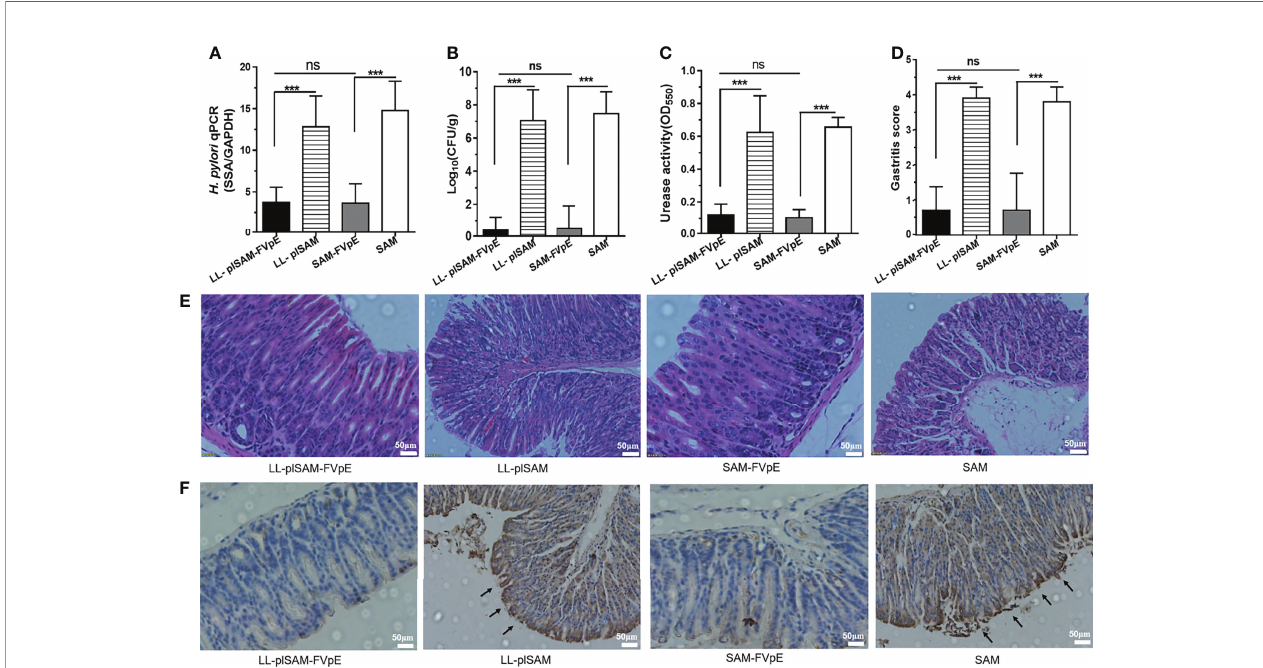
FIGURE 5 | Analysis of protective effects and gastric histopathology. (A – C) Mice were administered orally with L. lactis LL-plSAM-FVpE, L. lactis LL-plSAM, SAM-FVpE plus PA, or SAM plus PA, and then challenged with H. pylori . H. pylori load in the stomach was analyzed by quantitative culture, qPCR and rapid urease test. ***p <0.001; ns: not signi fi cant. (D, E) Moreover, gastric histopathological analysis was performed by HE staining and scoring of gastritis. Gastric tissues from mice immunized with LL-plSAM-FVpE or SAM-FVpE plus PA have lower in fl ammatory scores compared with mice immunized with LL- plSAM or SAM plus PA. Typical pictures of HE staining. Gastric tissue from mice vaccinated with LL-plSAM or SAM plus PA, exhibiting severe in fl ammatory in fi ltrates (100×). (F) IHC staining. There were clusters of H. pylori colonization in gastric tissue samples from mice administered with LL-plSAM or SAM plus